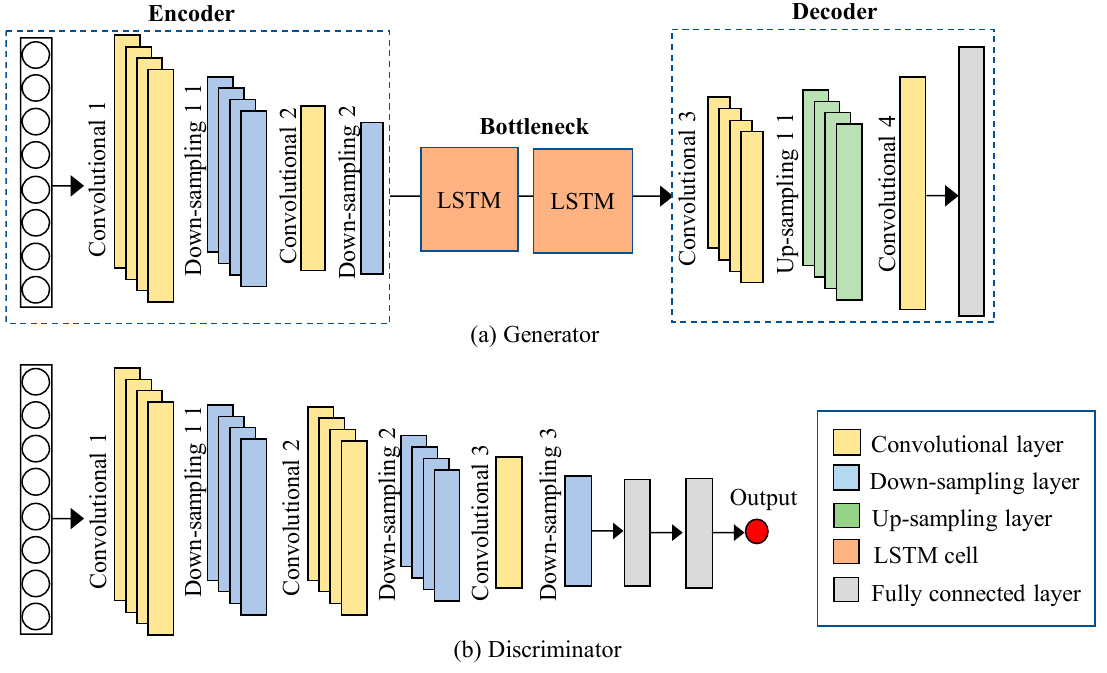
Figure 2. Architectures of the proposed Generator and Discriminator.